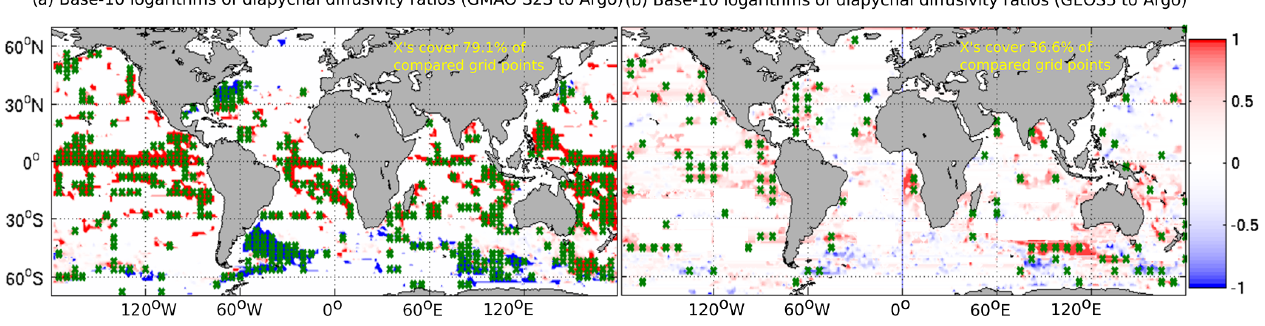
Figure A2. Shown are (a) the base-10 logarithms of the ratios of the time-averaged κ ρ, GMAO to κ ρ, Argo and (b) the base-10 logarithms of the ratios of the time-averaged κ ρ, GEOS5 to κ ρ, Argo . Each panels shows an average over 250–2000m depth. White areas in the ocean indicate insufficient Argo data to derive κ ρ, Argo . The green X marks indicate regions where the disagreement between κ ρ, GMAO or κ ρ, GEOS5 and κ ρ, Argo is greater than a factor of